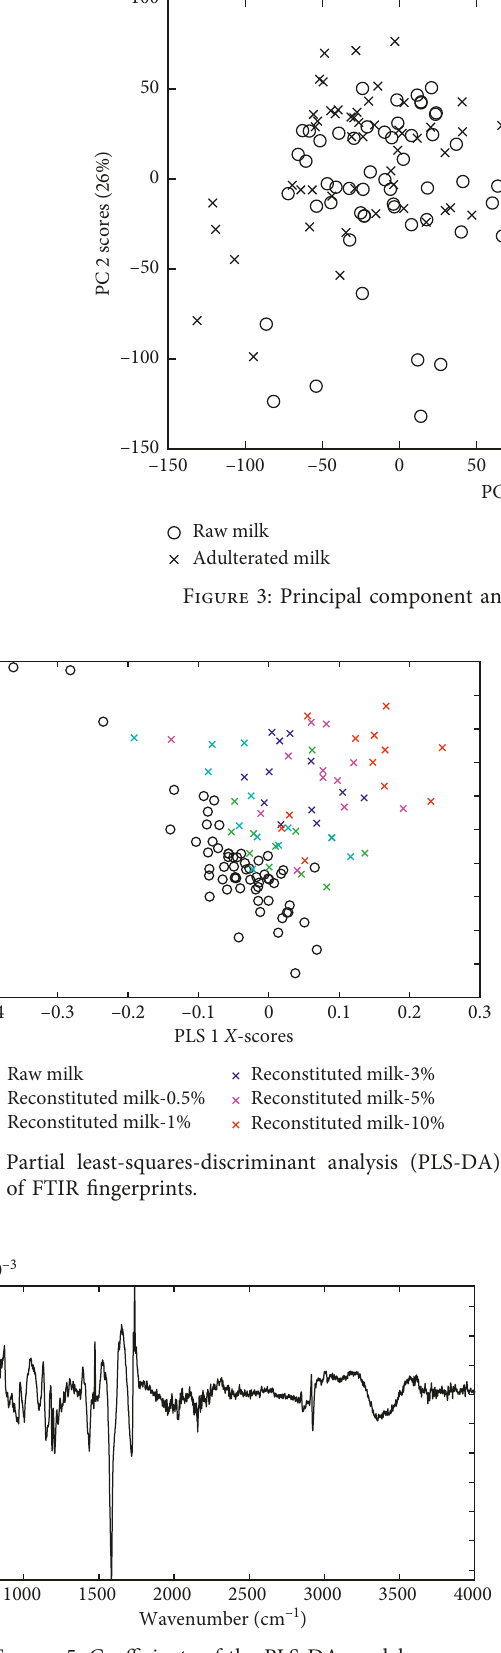
Figure 5: Coefficients of the PLS-DA model.